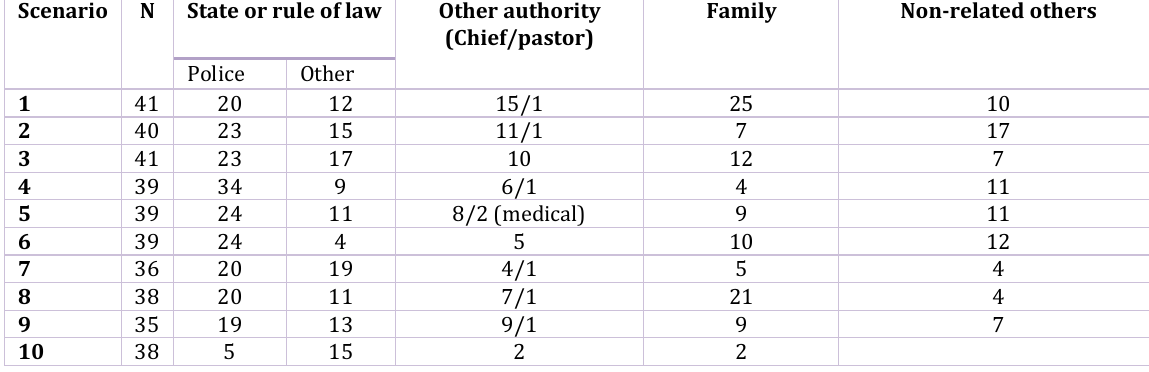
Table 3: Distribution of authorities from whom women who are vulnerable to gender violence can seek